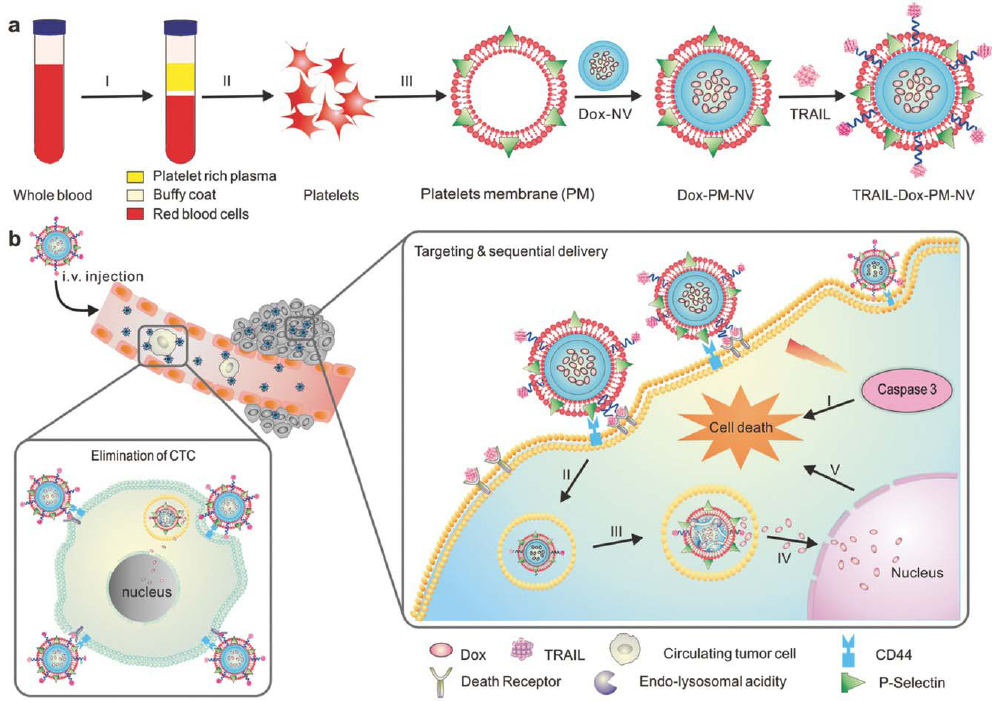
Figure 5. Schematic showing mechanism of drug loaded platelet membrane coated nanovehicle for targeted and sequential drug delivery. ( a ) Isolation and extraction of platelet membranes, coating it over core doxorubicin (DOX) nanovehicle (DOX_NV) and TRAIL conjugated platelet membrane; ( b ) TRAIL ‐ DOX nanovehicle (NV) capture the circulating tumor cells by specific affinity of P ‐ selectin and CD44 receptors in cancer and triggers the sequential release of TRAIL ‐ DOX NV. (I) Interaction of TRAIL and death receptors initiates apoptosis signals and (II) internalization of TRAIL ‐ DOX NV (III) TRAIL ‐ DOX NV dissociation by acidity of lyso ‐ endosome (IV) release of DOX in nucleus (V) DOX induced intrinsic apoptosis. Reproduced with permission from reference [70]. Copyrights © 2015 John Wiley and Sons.